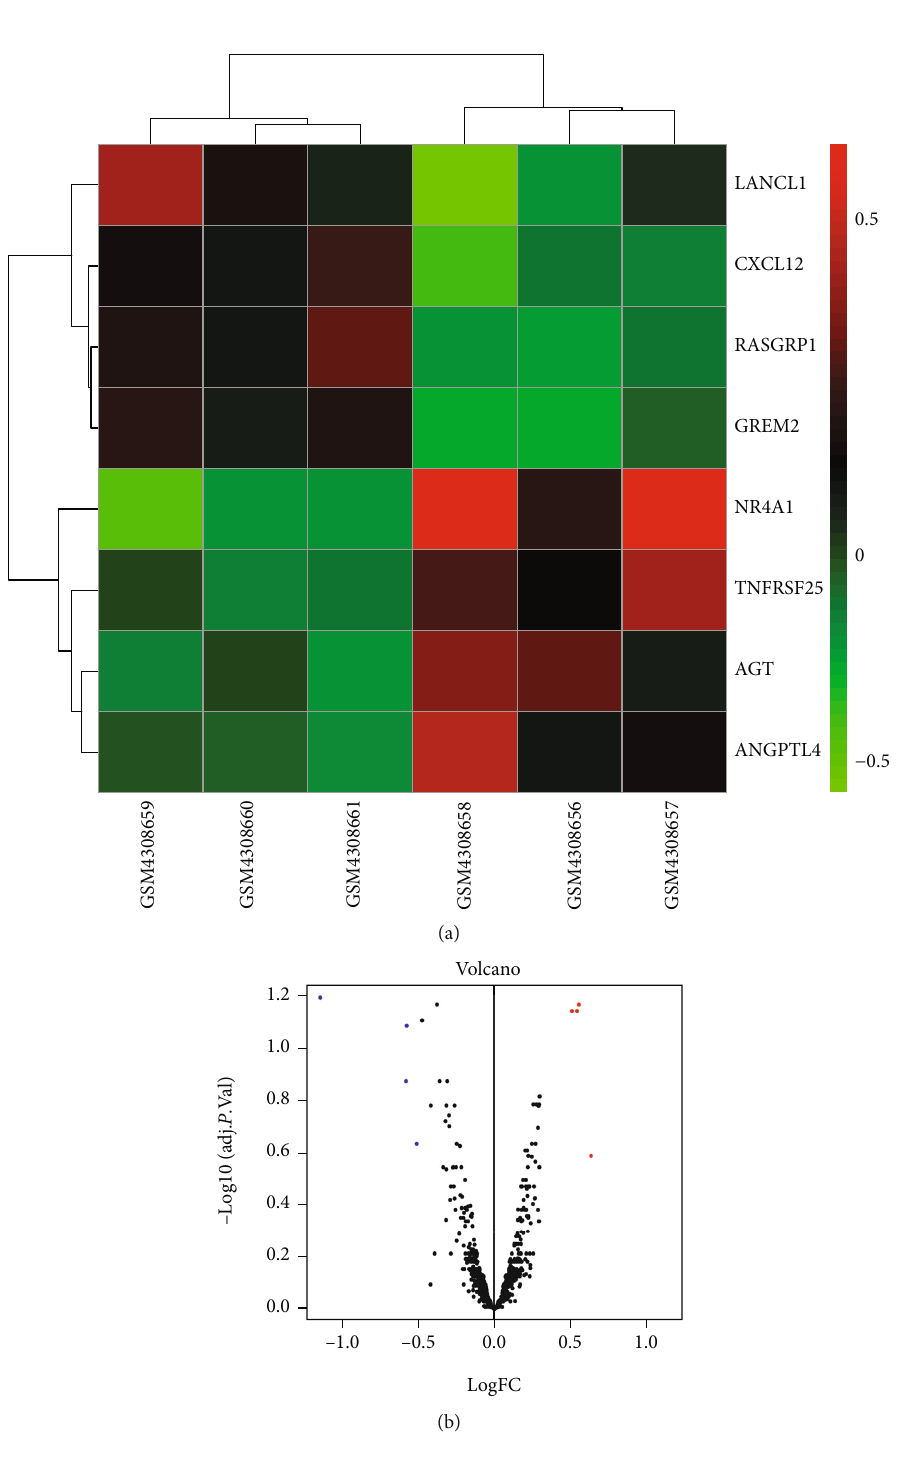
Figure 1: DEGs in the data set: (a) Heatmap of 8 immune DEGs; (b) volcano map of the immune genes; blue represents downregulated immune DEGs, and red represents upregulated immune